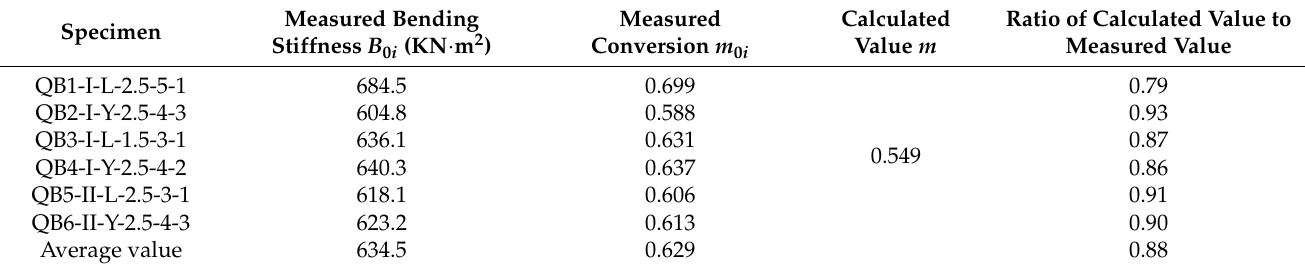
Table 7. Comparison between calculated and measured values of sheathing effect